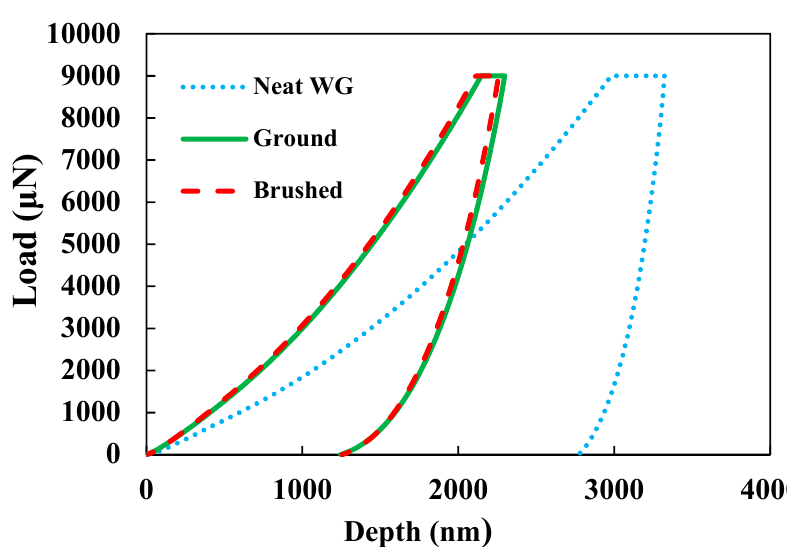
Figure 5. Load vs. displacement curves measured top-down.